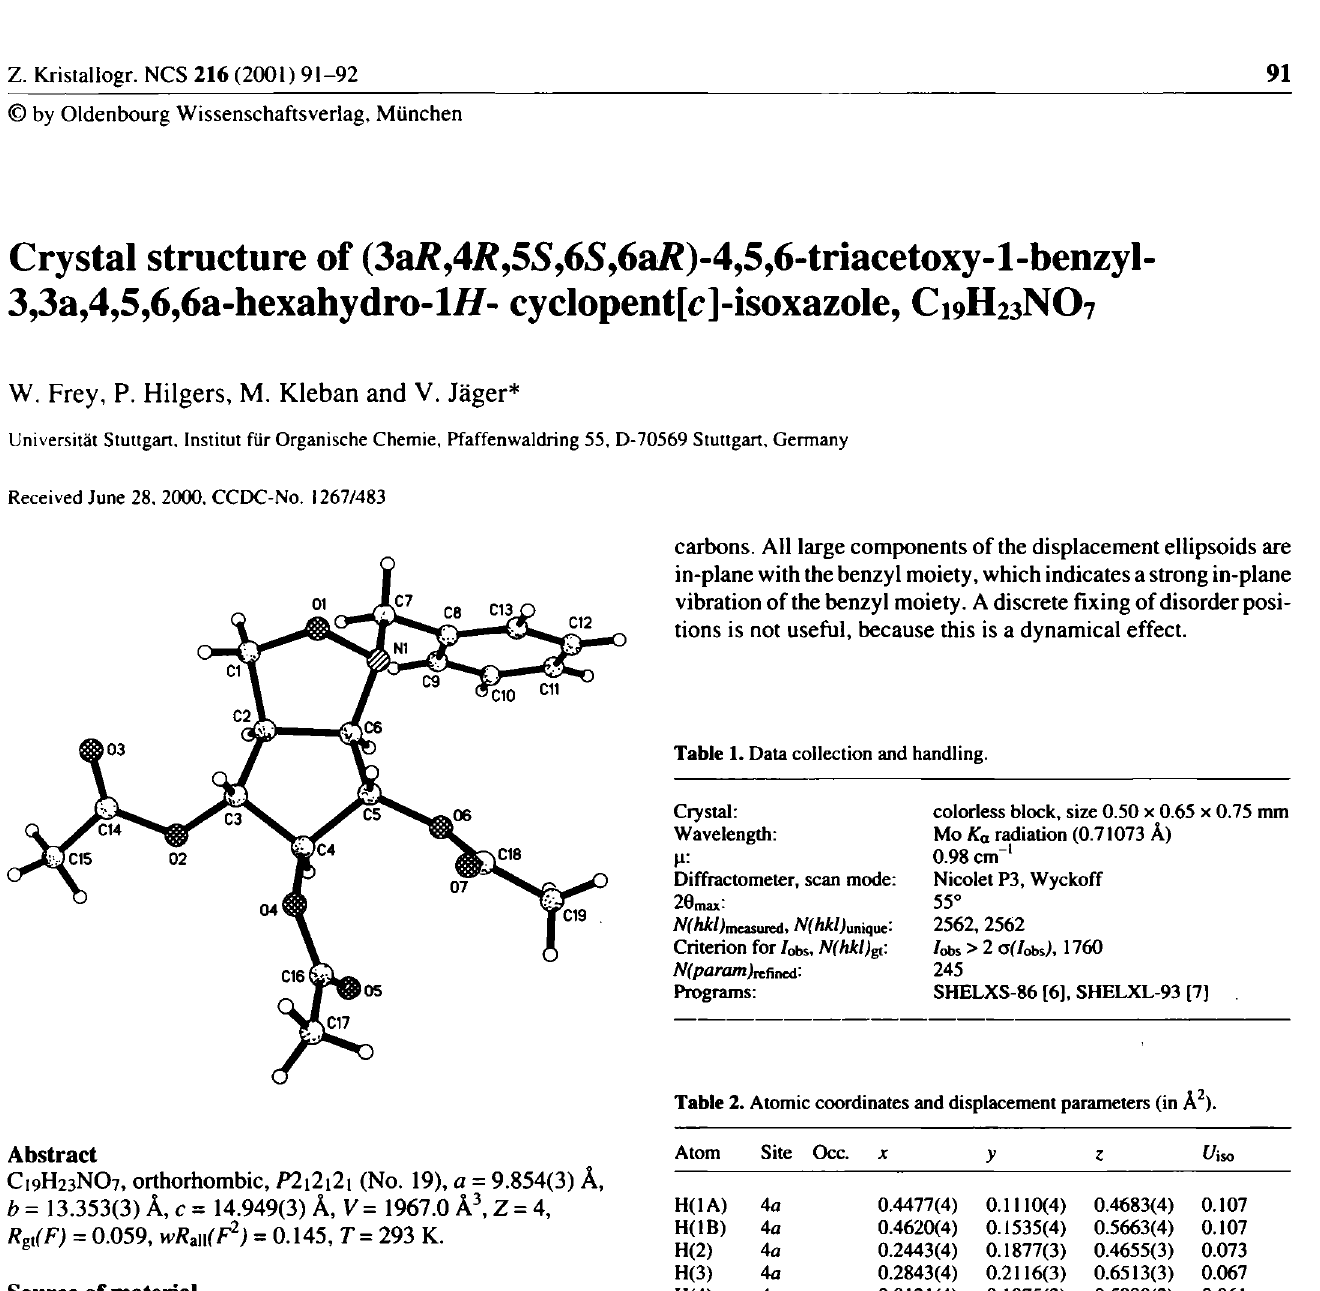
Table 2. Atomic coordinates and displacement parameters (in A 2